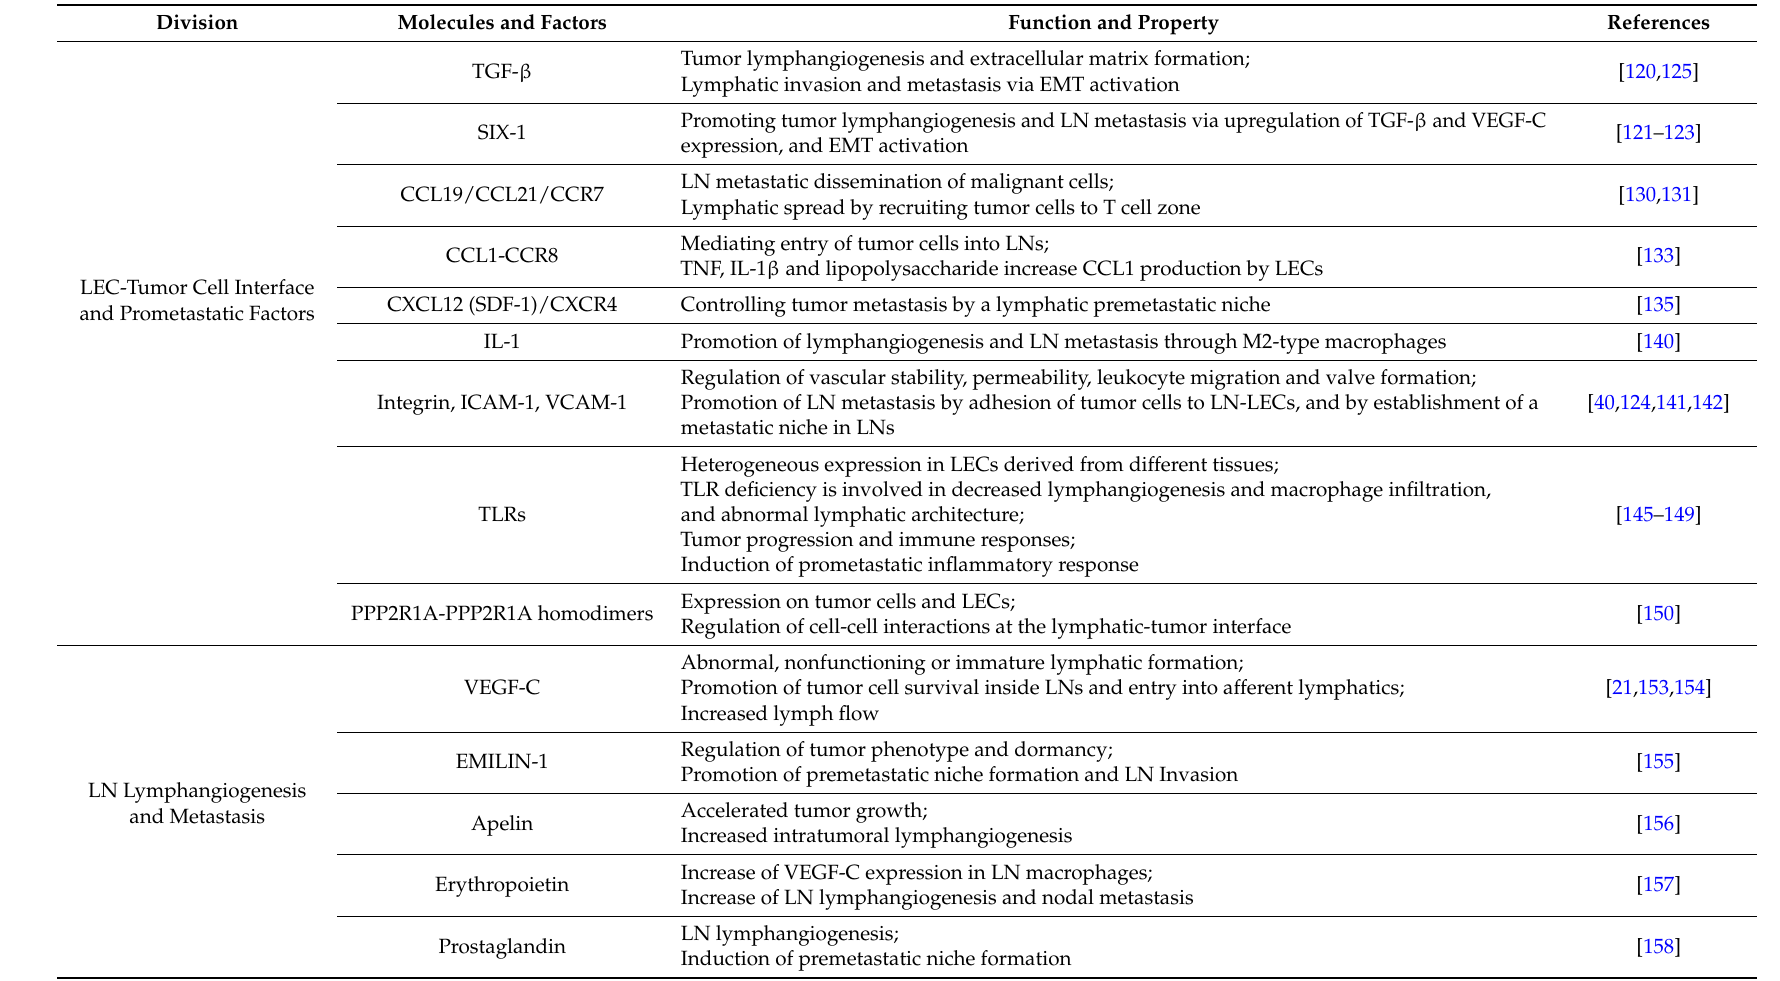
Table 2. Molecules and factors relating to intranodal LECs and LN